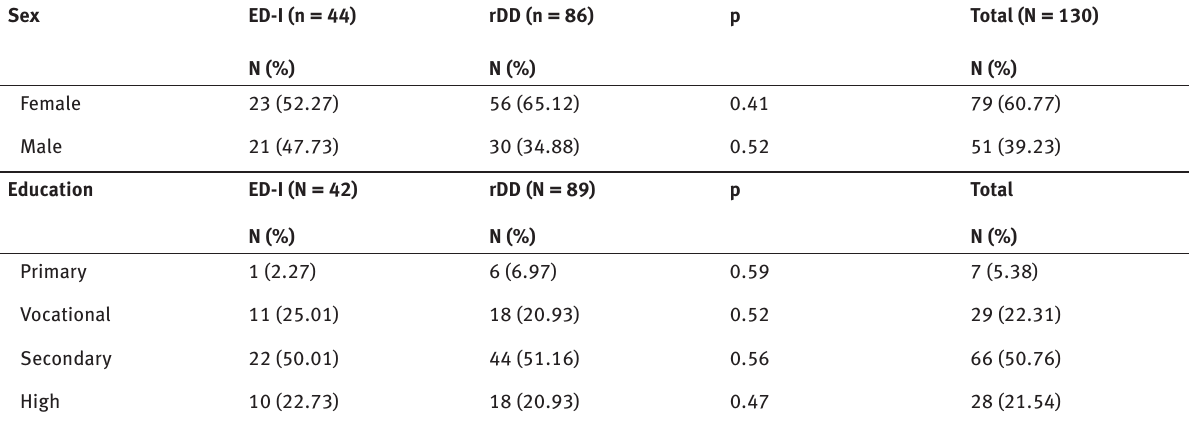
Table 1: The comparison of the study groups in terms of sex and education. Sex